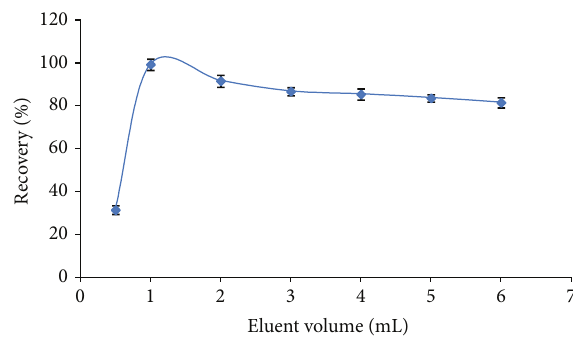
Figure 8: Effect of extraction time on the recovery of CV. Con- ditions: pH: 9, amount of CV: 50 𝜇 gL −1 , sample volume: 25 mL, amount of sorbent: 15mg, and eluent: glacial acetic acid.